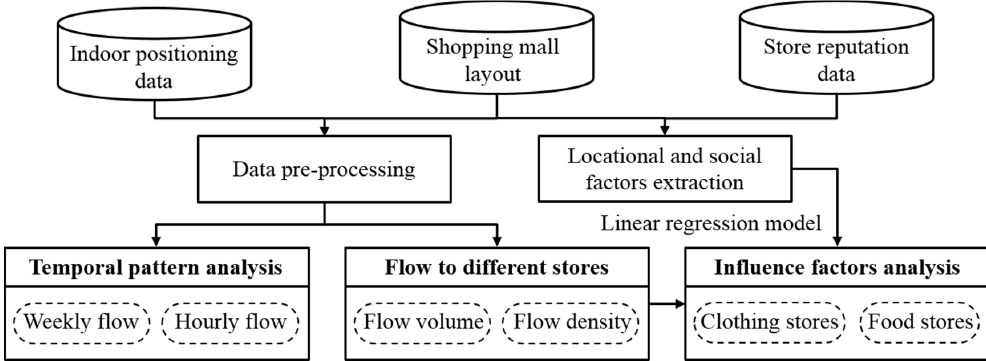
Figure 4. Analysis framework for customer flows in two shopping malls.